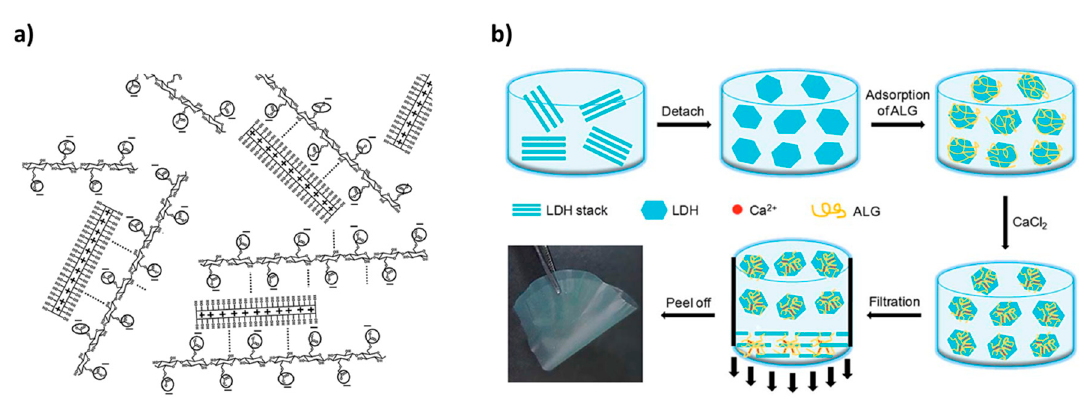
Figure 6. ( a ) Stabilization of the MgAl-LDH-CMC hybrid particle by electrostatic-driven interactions. Reprinted from Ref. [98]. Copyright (2014) with permission from Elsevier. ( b ) Production process of hybrid NiAl-LDH / Alginate-Ca 2 + film. Reproduced from Ref. [100]—Published by The Royal Society of Chemistry.